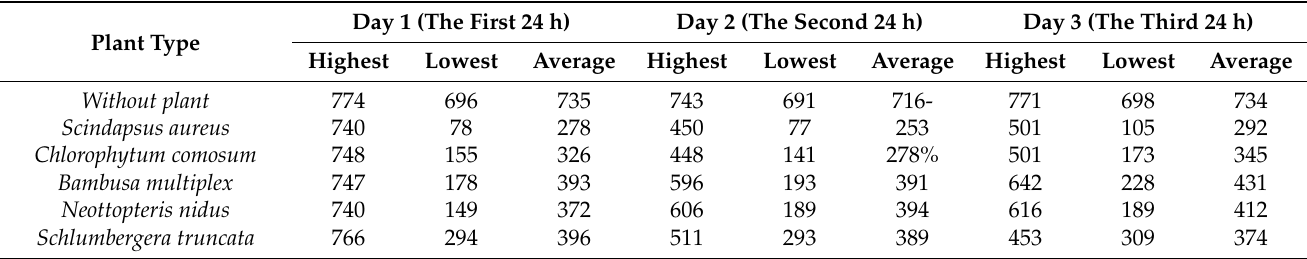
Table 2. Comparison of CO 2 concentration in sealed chambers in the natural lighting environment.